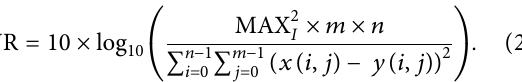
algorithm in Algorithm 1 to generate two mean- ingful share